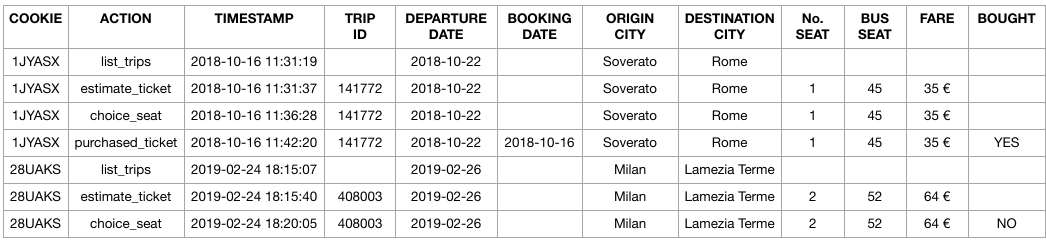
Figure 4. Example of the log